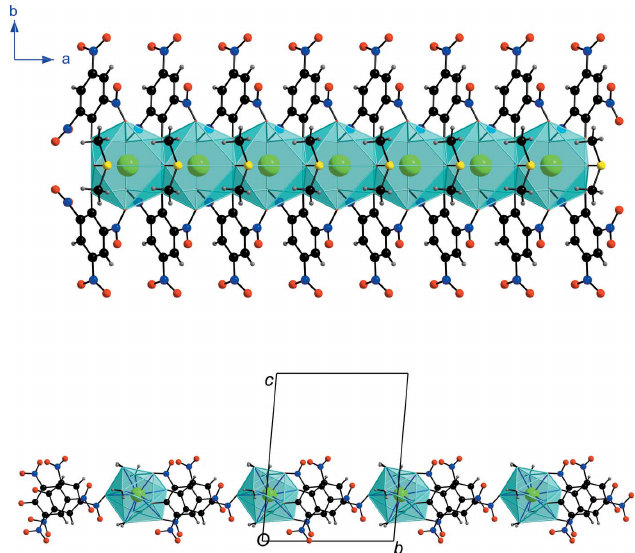
Figure 4 Face sharing {BaO 10 } polyhedra in the crystal structure of ( 1 ) (top) versus discrete {BaO 10 } polyhedra in the crystal structure of [Ba(H 2 O) 5 (C 6 H 2 - N 3 O 7 ) 2 ] (cid:2) H 2 O (bottom).